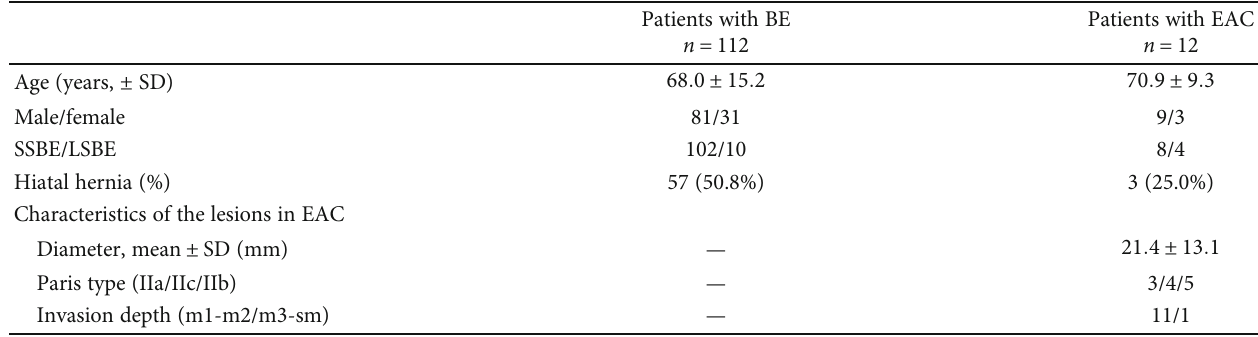
Table 1: Characteristics of the patients.